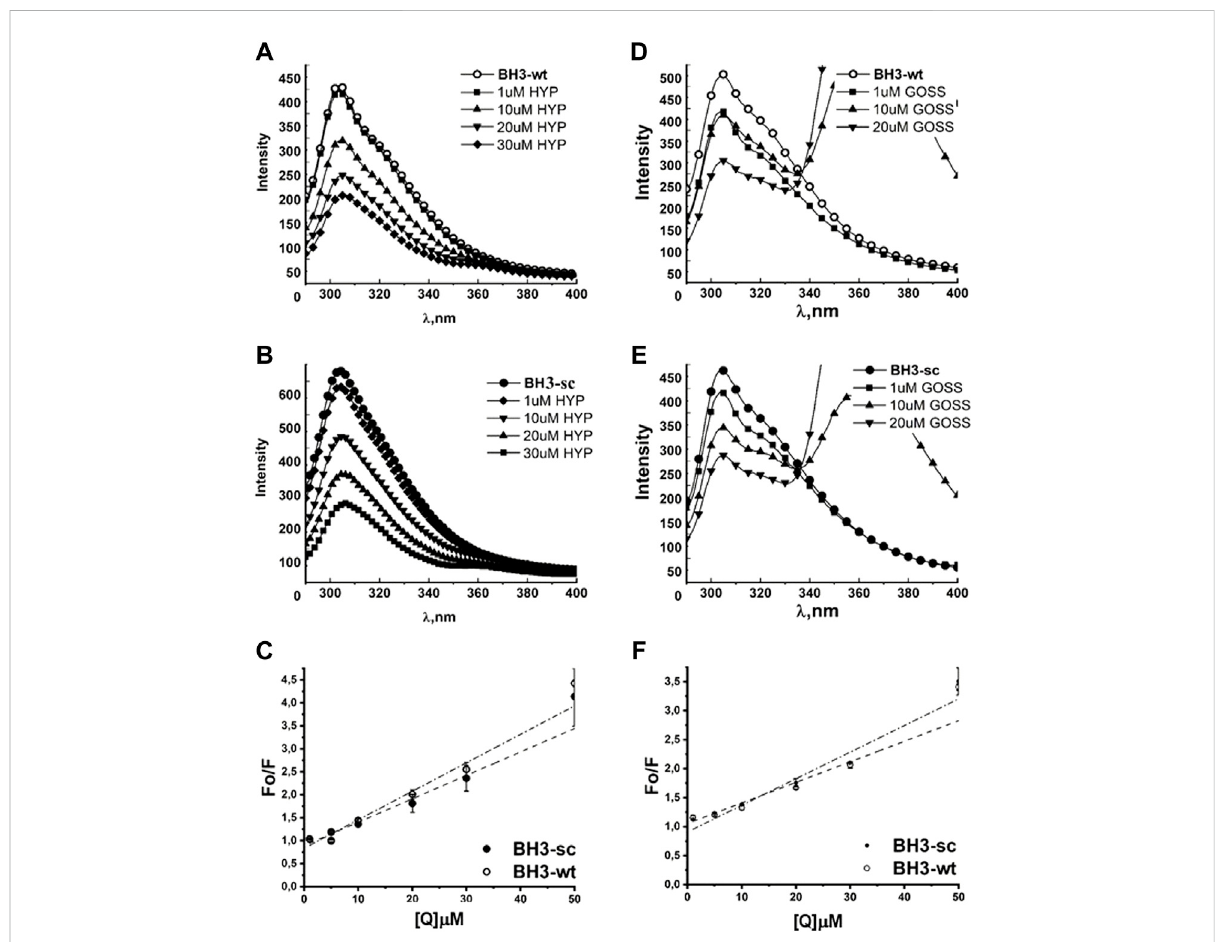
FIGURE 3 HypdisplaysstrongerquenchingofBH3peptides fl uorescencespectrathanGoss.TheFluorescencequenchingspectraofBH3-scandBH3-wt with different concentration of Hyp (A,B) and Goss (D,E) . (C) The linear fi t of Stern-Volmer curves for BH3-sc and BH3-wt corresponding to quenching spectra in (A,B) . (F) The linear fi t of Stern-Volmer curves for BH3-sc and BH3-wt corresponding to quenching spectra in (D,E) . All of the measurements were done in three independent measurements according to protocols described in Methods